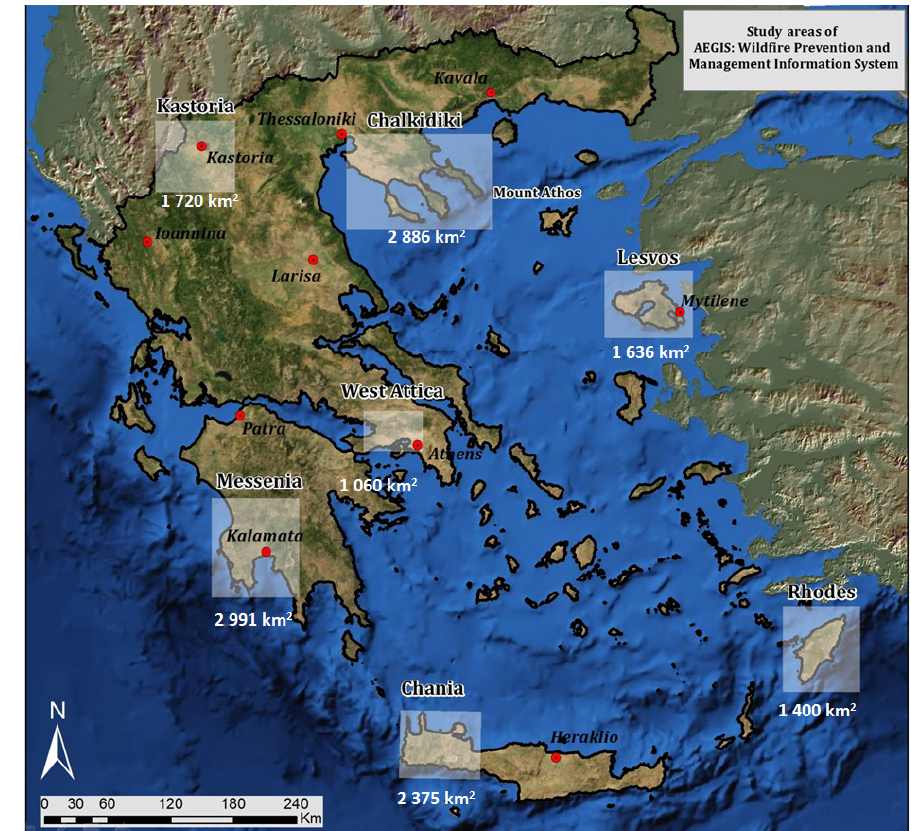
Figure 1. The seven study areas used to test AEGIS in Greece.